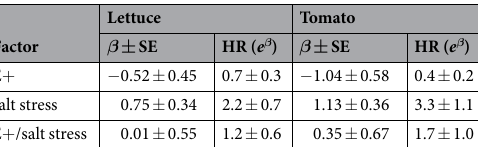
Table 1. Parameters of the regressions of the Cox proportional-hazards models. For both species the three influencing factors (i) E + (with endophytes in 50 mM NaCl), (ii) salt stress (without endophytes in 150 mM NaCl), and (iii) E + /salt stress (with endophytes in 150 mM NaCl) were evaluated against the control condition (without endophytes in 50 mM NaCl). The models are based on 200 individuals for each species monitored for 12 weeks and 61 lethal events for lettuce and 56 for tomato. HR: hazard ratio, SE: standar error. The variance of HR was calculated on the basis of the 95% confidence interval of β ([ β -SE.. β + SE] → [HR min ..HR max